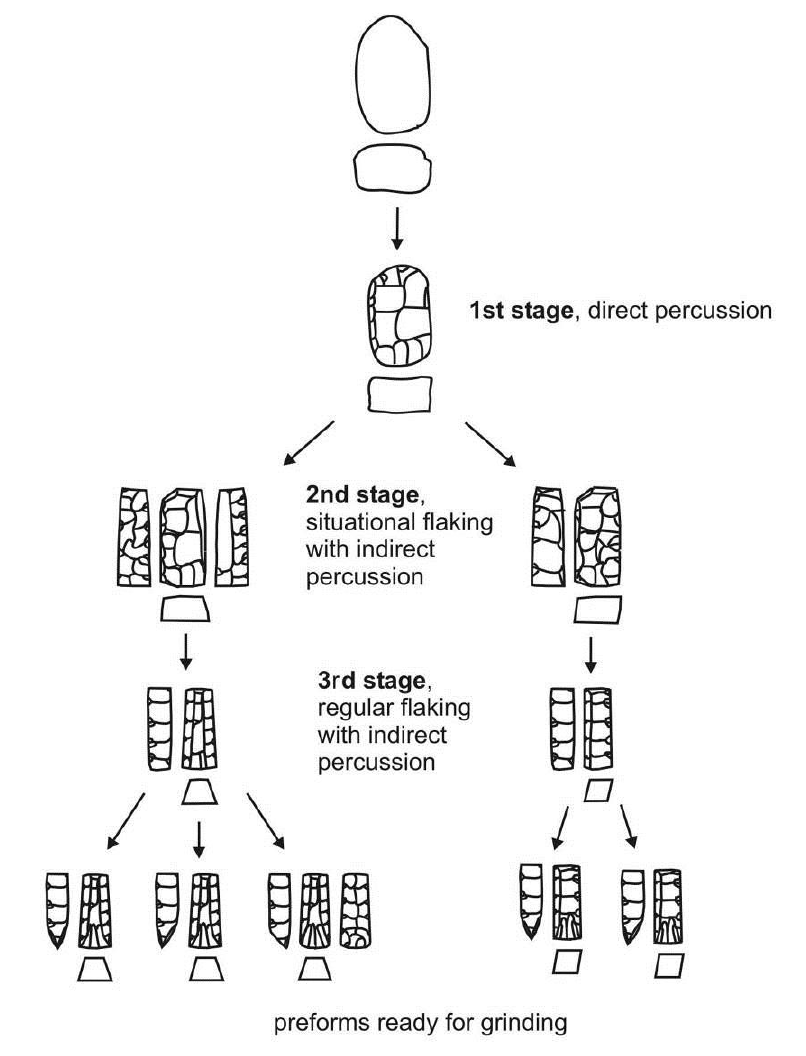
Figure 6. Technology of Russian Karelian tools, simplified reduction